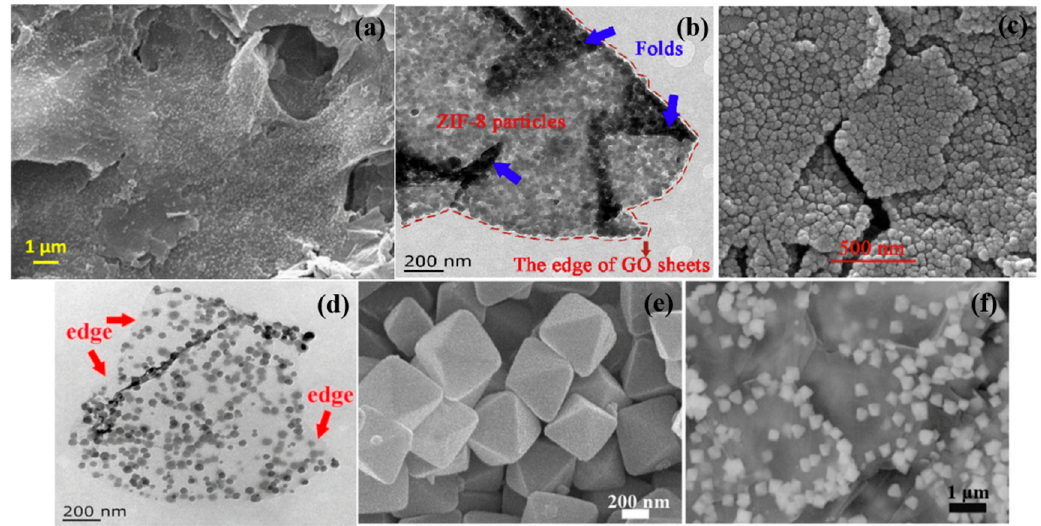
Figure 9. ( a ) SEM image of Co/Zn-MOF@GO nano-hybrids with big crystal distributed; ( b , c ) TEM and SEM of GPZ; ( d ) TEM of nano-ZIF-8@GO; ( e , f ) SEM image of UiO-66-NH 2 , TEM image of